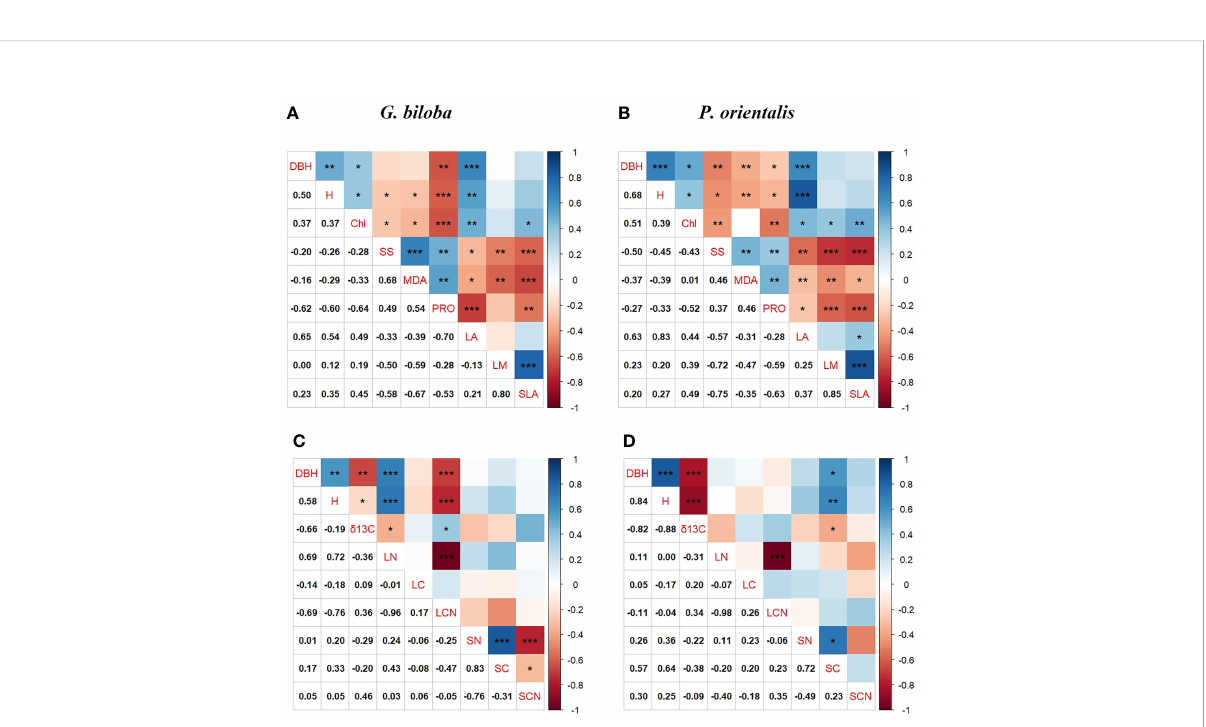
FIGURE 9 Pearson ’ s correlations among the tree growth, leaf physiology, and leaf morphology for G biloba (A) and P. orientalis (B) , respectively, and among the tree growth, carbon isotope composition ( d 13 C), and leaf and soil nutrient content for G biloba (C) and P. orientalis (D) , respectively. Asterisks represent statistical signi fi cance (*, P < 0.05; **, P < 0.01; ***, P <